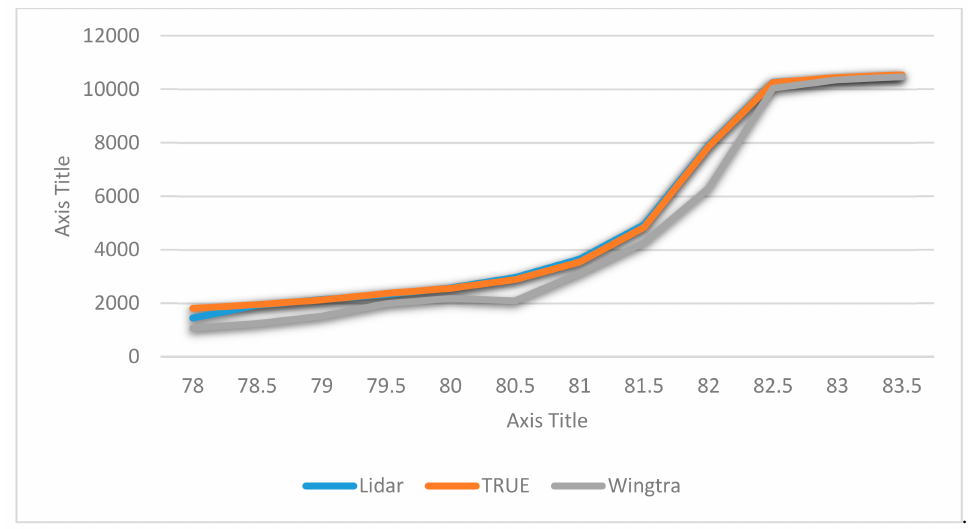
Figure 6. Relationship between the detected inundation area for di ff erent data sources and water